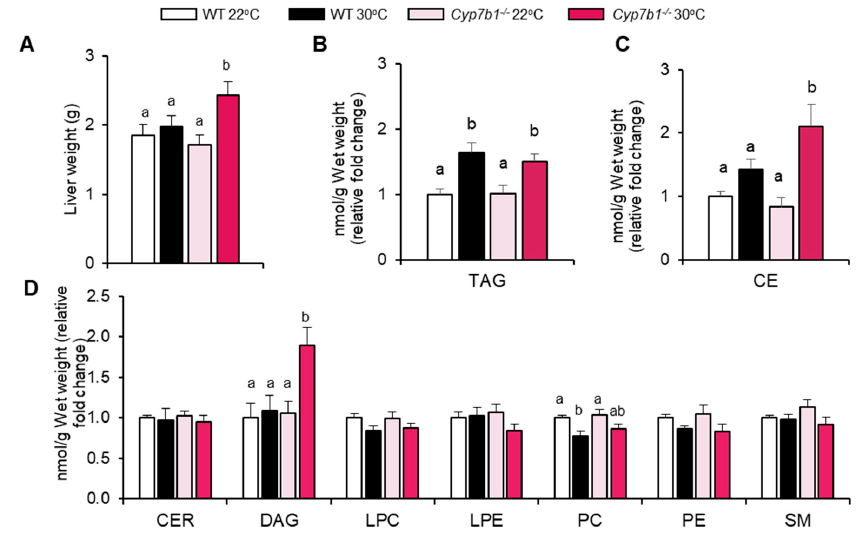
Figure 2. Hepatic accumulation of specific lipid classes in CYP7B1-deficient mice housed at ther- moneutrality. Cyp7b1 − / − and WT littermates housed under 22 ◦ C or 30 ◦ C were fed a CD-HFD for 8 months. ( A ) Liver weight. ( B ) Hepatic trigylcerides (TAG) and ( C ) cholesteryl esters (CE). ( D ) Hepatic ceramides (CER), diacylglycerols (DAG), lysophosphatidylcholines (LPC), lysophos- phatidylethanolamines (LPE), phosphatidylcholines (PC), phosphatidylethanolamines (PE), and sphingomyelins (SM). Data are shown as mean values ± SEM (n = 8), different letters indicate significant differences between groups ( p < 0.05) determined by two-way ANOVA.